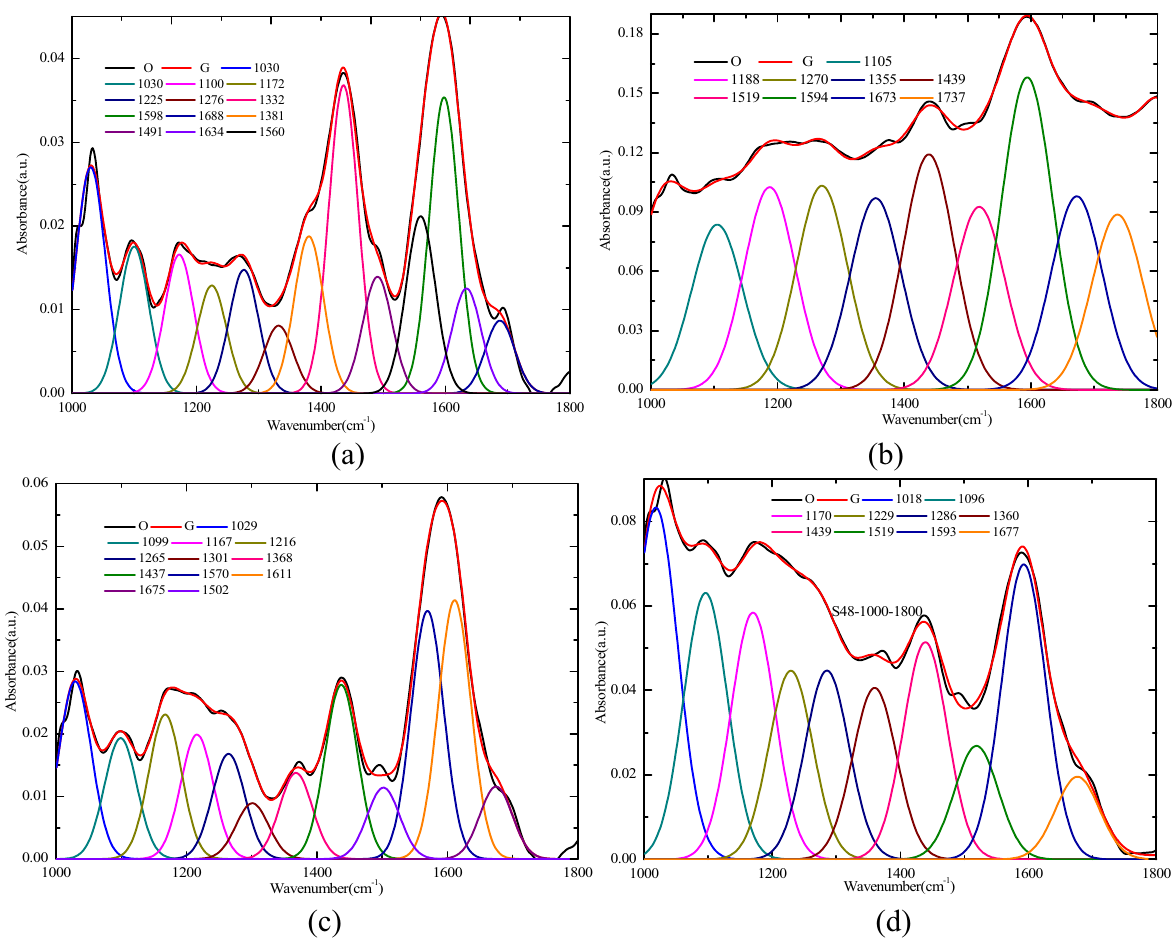
Figure 3. Fitted curve of FTIR spectrum ranging from 1000 to 1800 cm −1 . ‘O’represents the original test spectral line, and ‘G’represents the newly generated spectral line after multipeak fitting. ( a ) R C , ( b ) Sad-8 h, ( c ) Sad-24 h, ( d ) Sad-48 h.